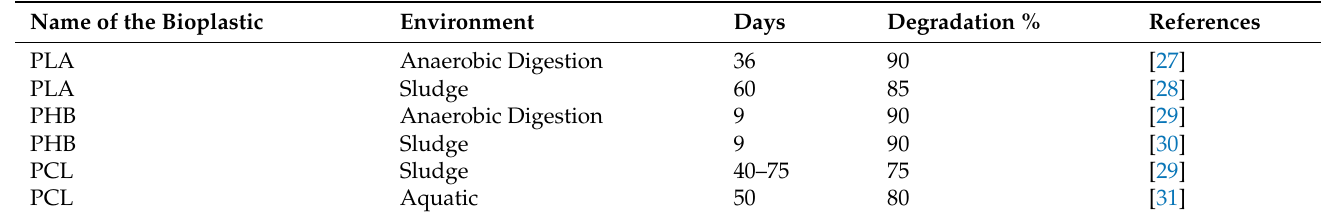
Table 2. Bioplastics degradation rate (adapted from